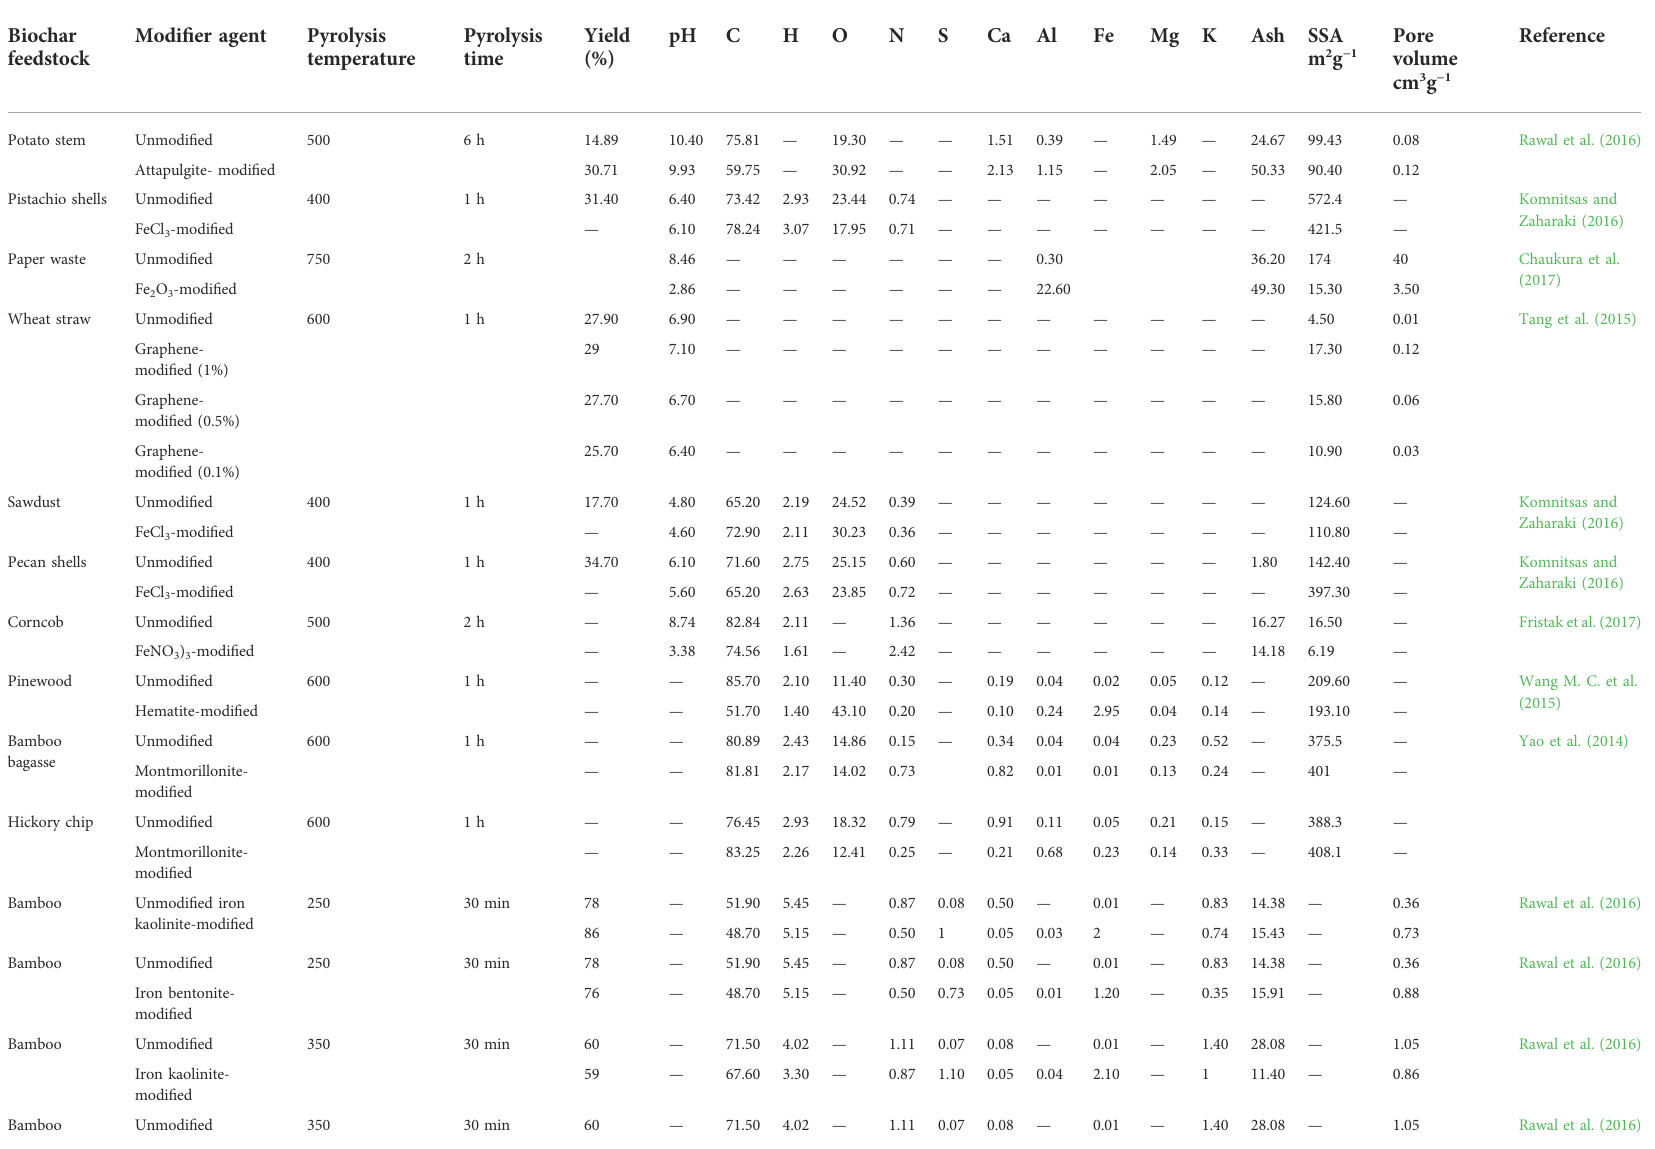
TABLE 3 Properties of engineered biochar-based composite synthesized from various feedstocks. Biochar feedstock